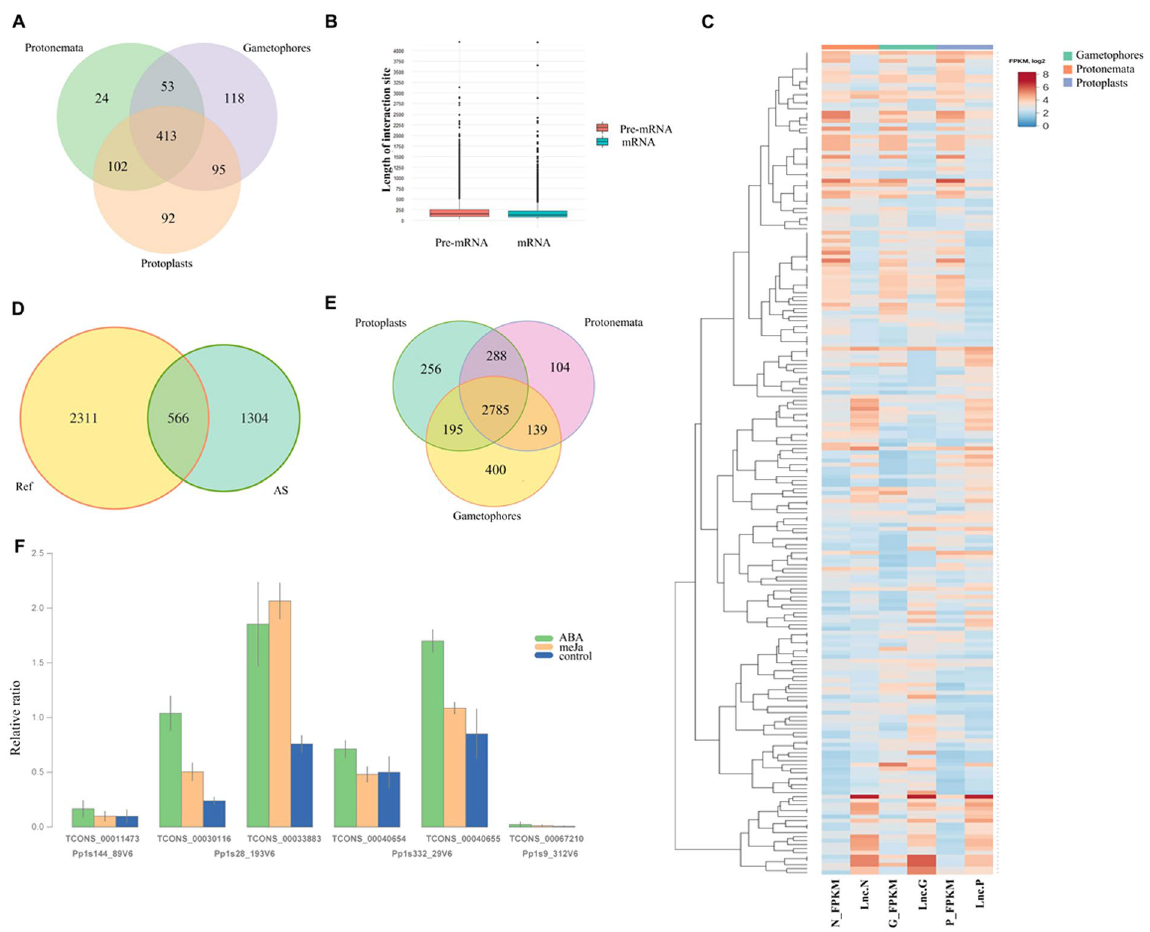
Figure 4. ( A ) Venn diagram showing lncRNAs distribution in gametophores, protonemata and protoplasts. ( B ) Bar plot showing the length of interaction sites between lncRNA-mRNAs and lncRNA-pre-mRNAs. ( C ) Heatmap representing expression patterns of the potentially interacted lncRNAs and mRNAs in gametophores, protonemata and protoplasts. N_FPKM, G_FPKM, P_FPKM ≥ indicating the expression profiles of mRNAs in protonemata, gametophores and protoplasts, respectively. Lnc.N, lnc.G and lnc.P indicating the expression profiles of lncRNAs in protonemata, gametophores and protoplasts, respectively; ( D ) Venn diagram representing the overlap of unique interaction sites between reference (Ref) and alternative (AS) isoforms. ( E ) Venn diagram showing the landscape of lncRNA:mRNA interaction sites in gametophores, protonemata and protoplasts. ( F ) Results of quantitative polymerase chain reaction (qRT-PCR) data for serine/arginine-rich (SR) genes after treatment of protonemata with 50 µ M abscisic acid (ABA) and 400 µ M methyl jasmonate (MeJA). Protonemata treated with ultrapure Milli-Q water were used as a